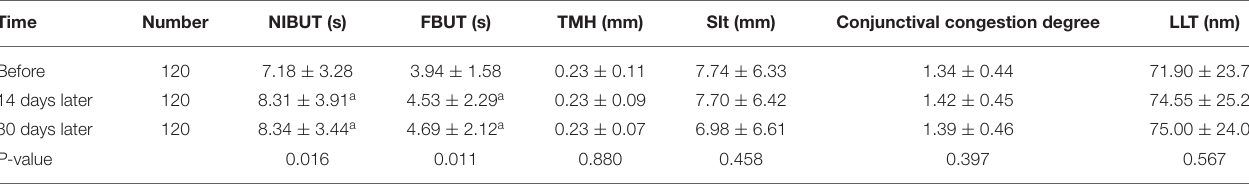
TABLE 2 | Changes in NIBUT, FBUT, TMH, SIt, LLT, and conjunctival congestion degree before and after treatment. Time Number NIBUT (s) FBUT (s) TMH (mm) SIt (mm) LLT (nm) Before